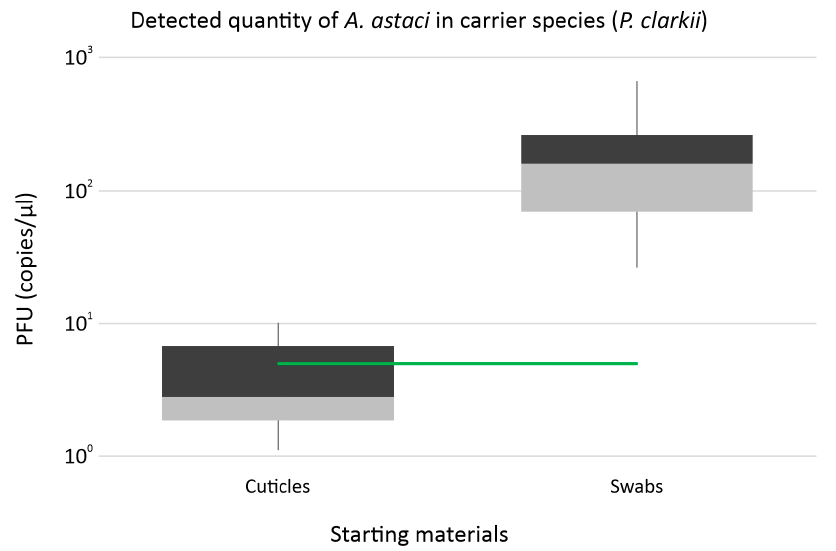
Figure 3. Comparison between sampling protocols carried out in P. clarkii after 8 weeks stabulation. The absolute quantifications are expressed as PCR Forming Units (copies/µL) in qPCR. The green line indicates the LoD level (5.00